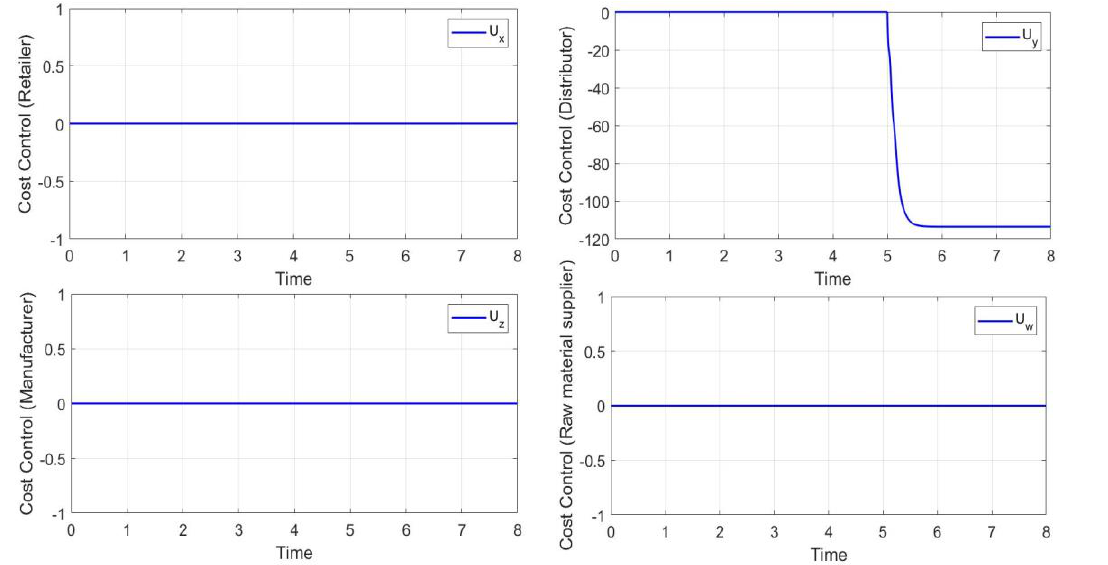
Fig. 12. Policy control in the only distributor for eliminate of the hyperchaos supply